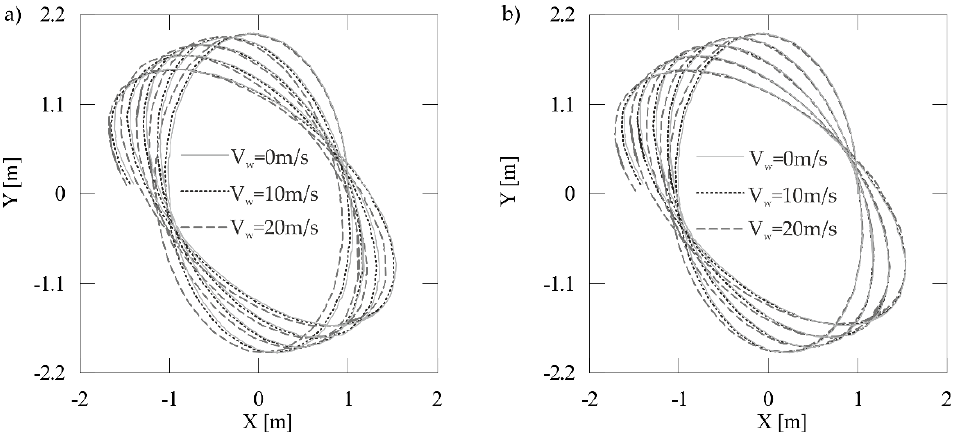
Figure 13. Projection of the trajectory of the carried load’s suspension point on the rotation plane for ( a ) the variable effective area and ( b ) fixed effective area.